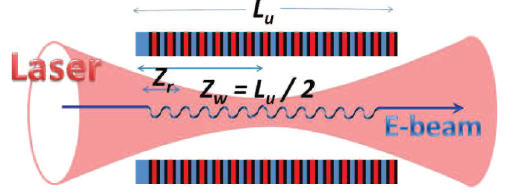
FIG. 1. Scheme for a diffraction dominated inverse free elec- tron laser accelerator.